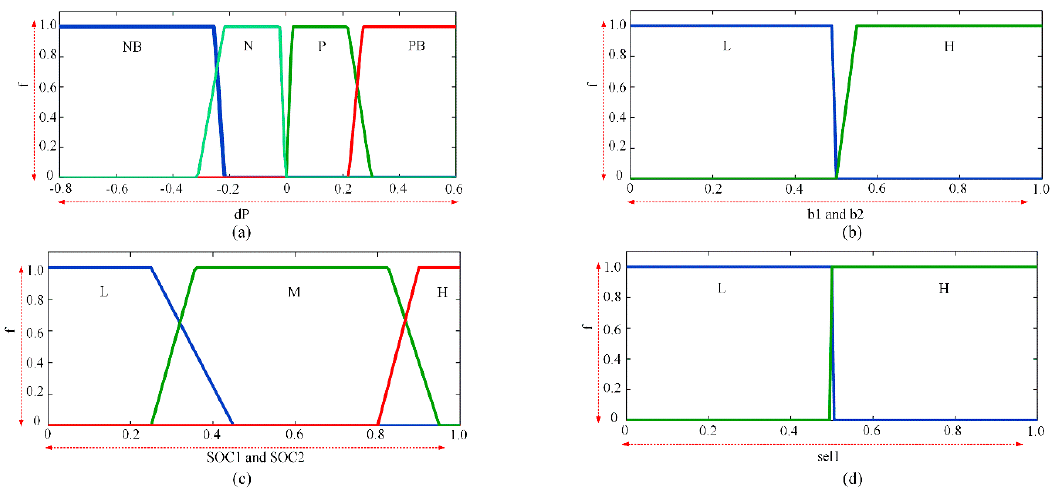
Figure 4. Membership functions of inputs and outputs for fuzzy controller.